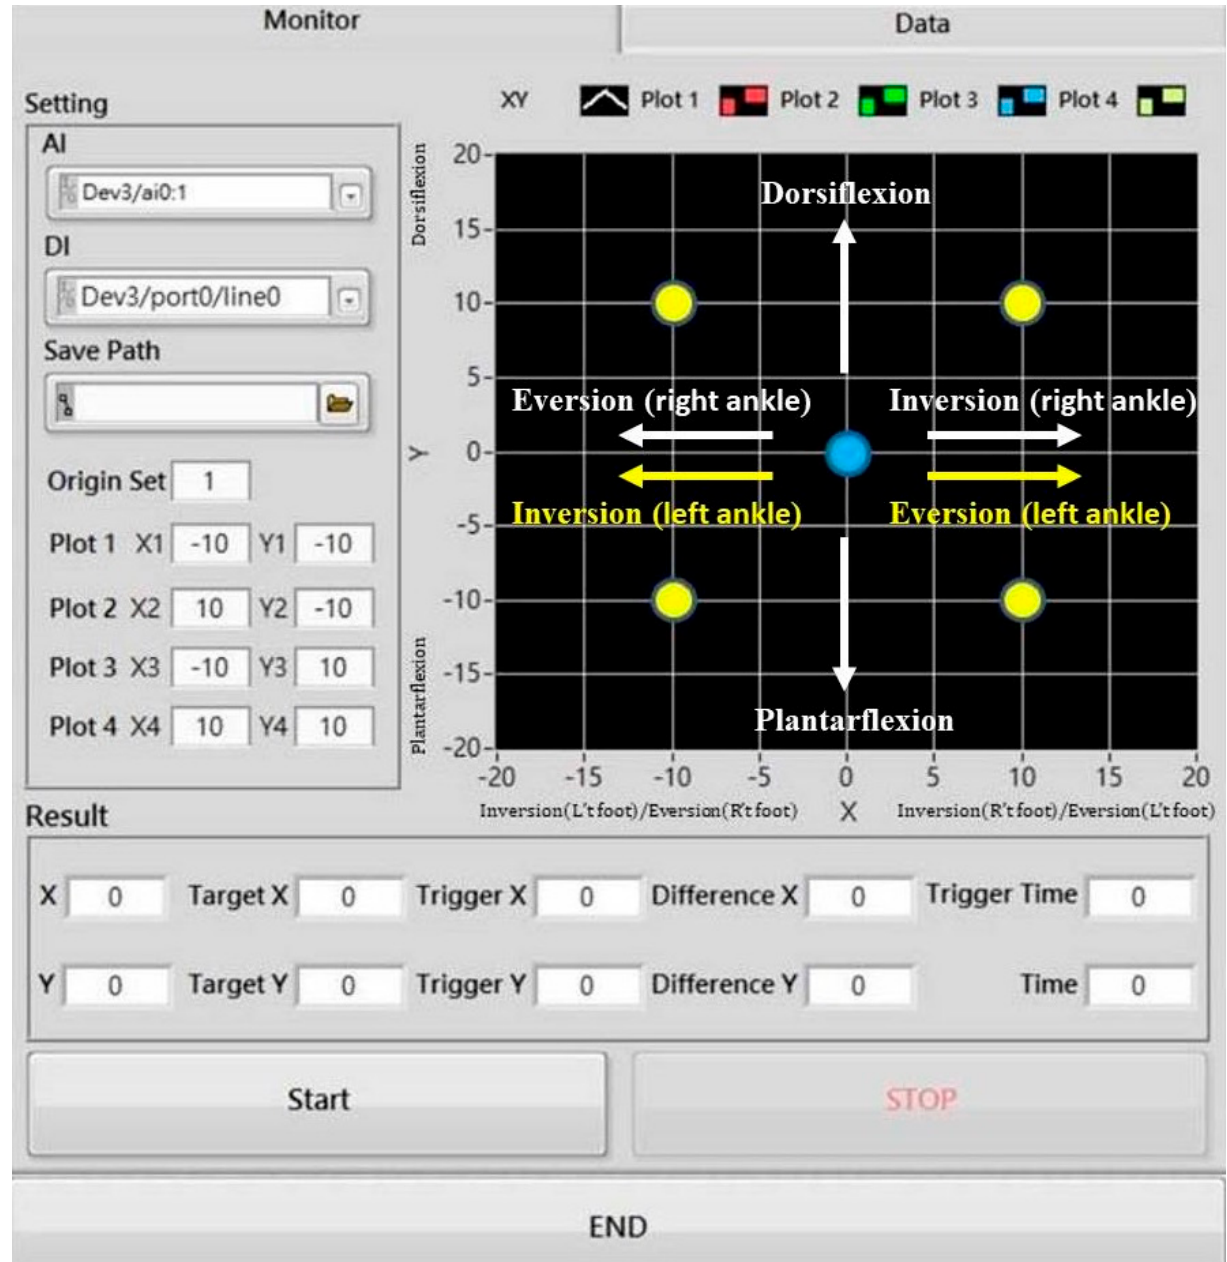
Figure 4. Control panel in LabVIEW for measuring muscle perceptions in four multiaxis test positions (plots 1–4).